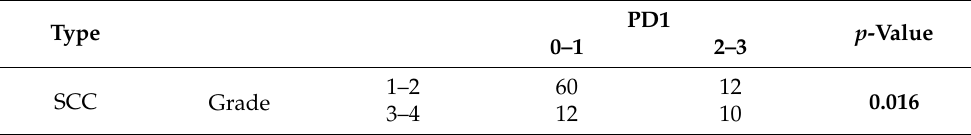
Table 2. Correlation between PD1 protein expression and tumor grading in lung